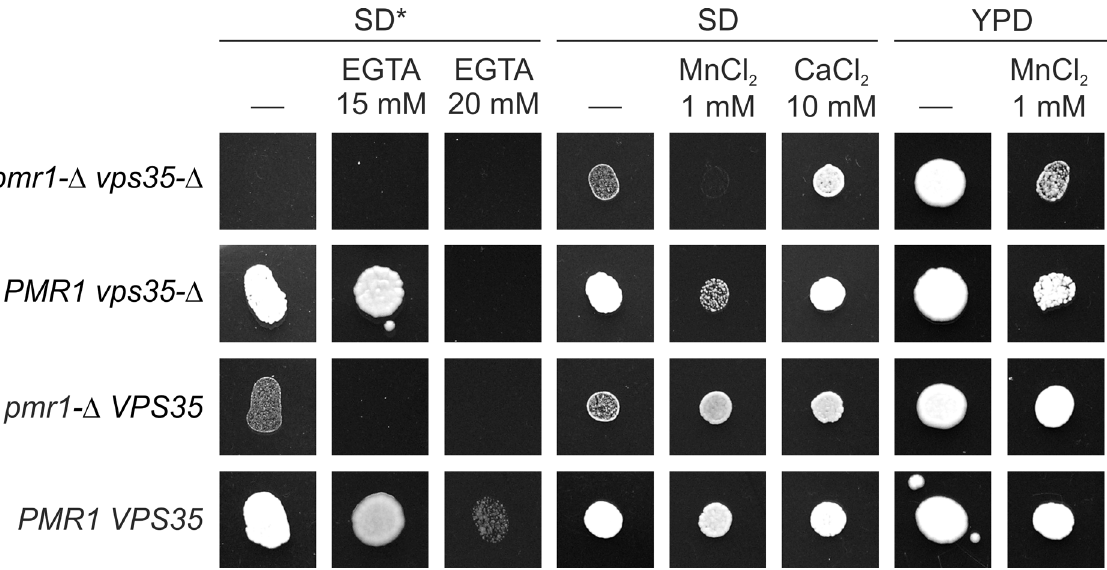
Fig 4. Effect of the vps35- Δ mutation on growth of strains with or without the PMR1 gene. Cell suspensions with equal densities were spotted onto corresponding media and grown for 2 days. The experiment was performed serial dilutions of cell suspensions (S6 Fig) and a representative dilution is shown in this figure. pmr1- Δ vps35- Δ , the 1MA27/12/GP1- Δ vps35 strain lacking the plasmid with PMR1 ; vps35- Δ , the 1MA27/12/GP1- Δ vps35 strain, pmr1- Δ VPS35 , the 1MA27/12/GP1 strain lacking the plasmid with PMR1 ; PMR1 VPS35 , the 1MA27/12/GP1